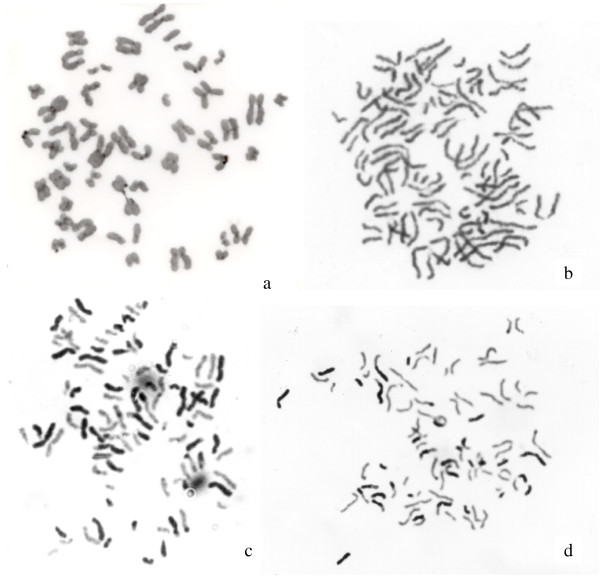
PCD figures. Propositus PCD figures are shown with Cd stain (a), giemsa stain (b), and sister chromatid differential stain from second (c), and third (d), cell cycle.